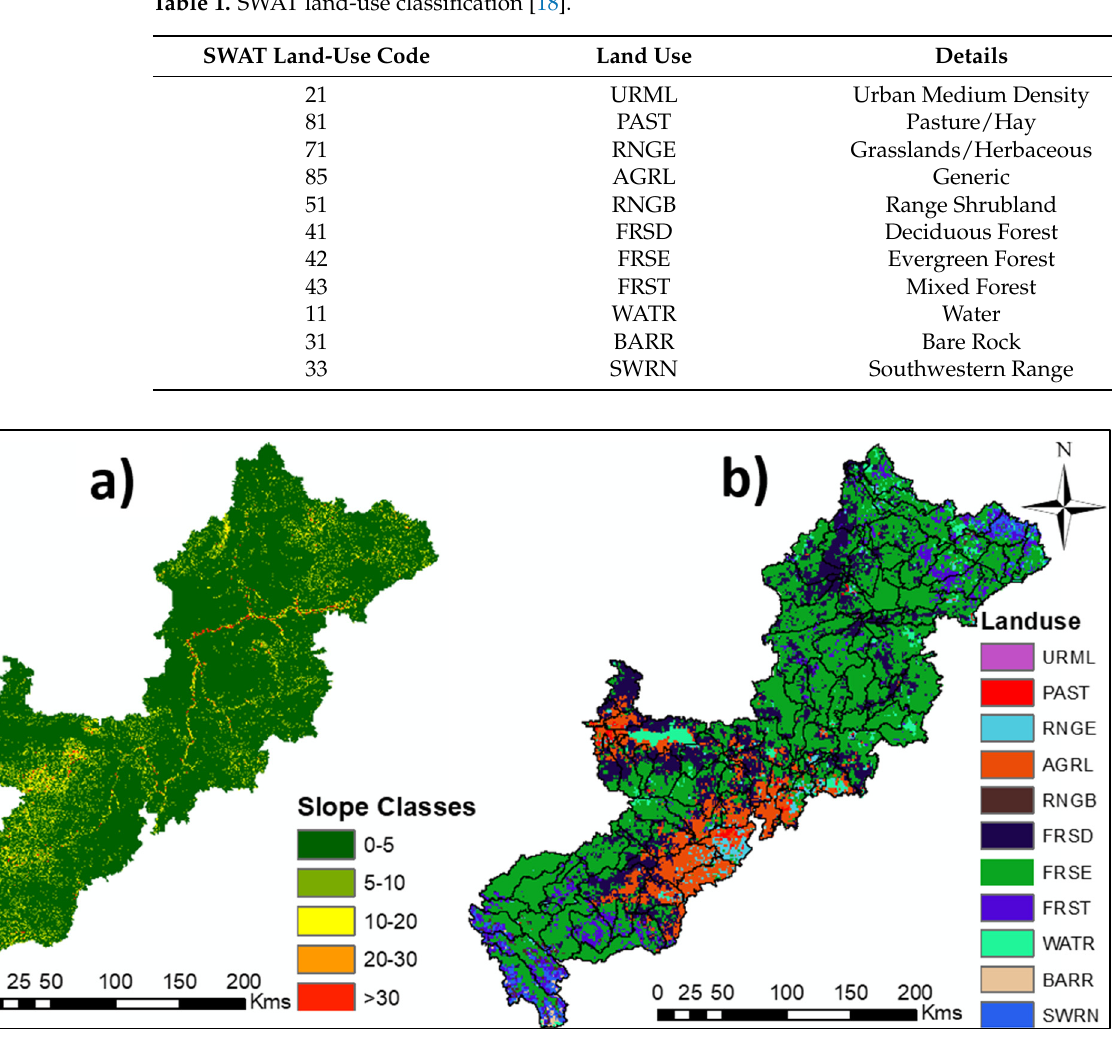
Table 1. SWAT land-use classification